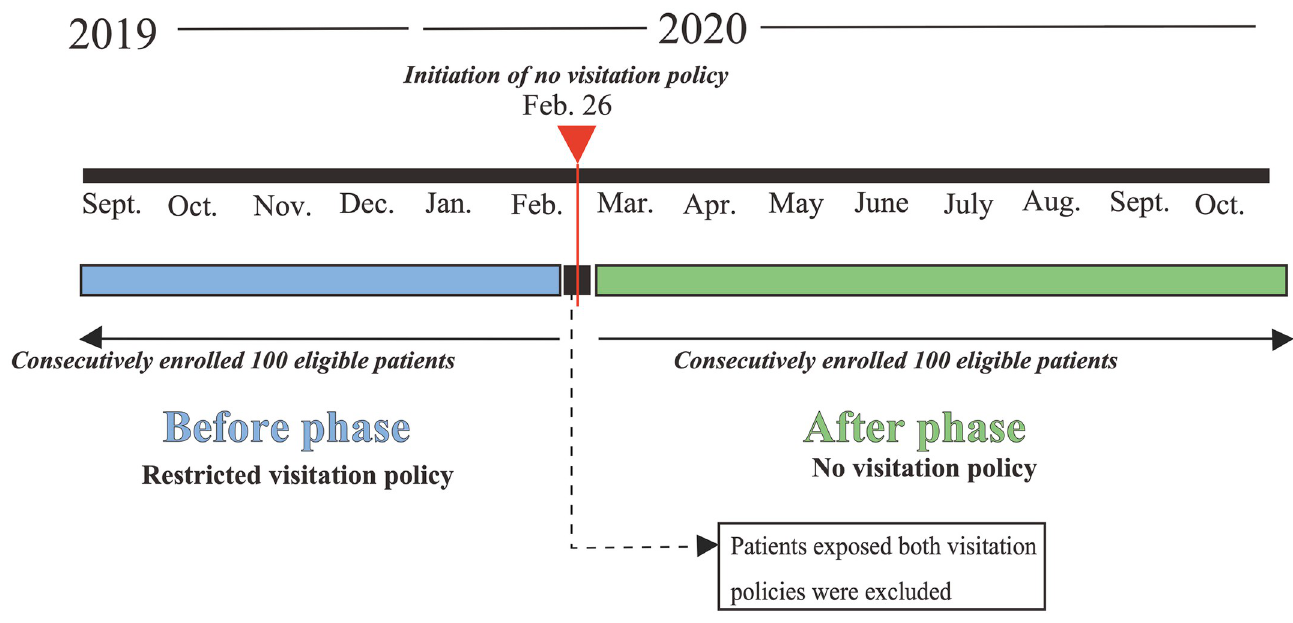
Fig 1. Schematic illustration of the recruitment